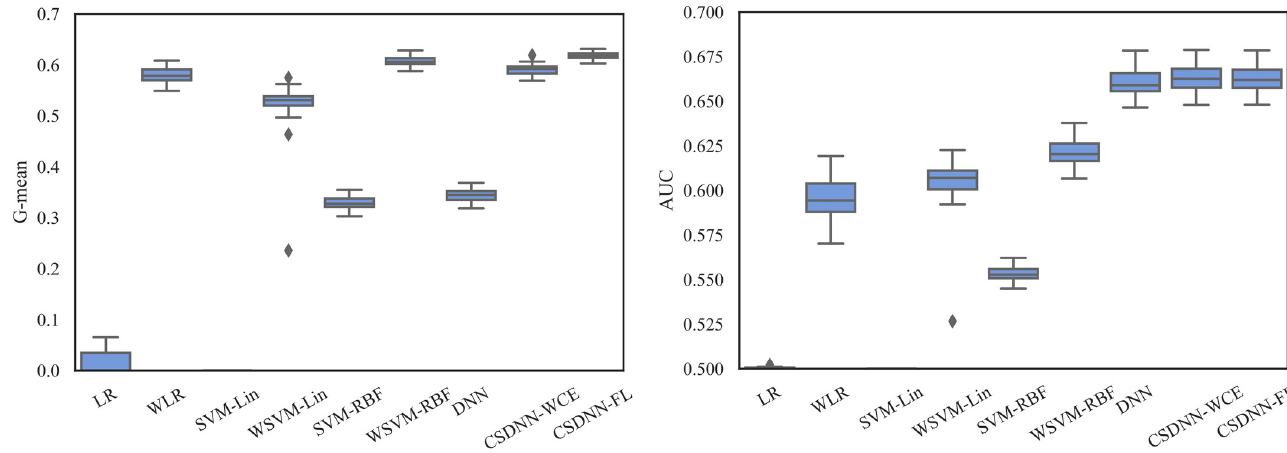
Fig 27. Robustness of CSDNN-FL and CSDNN-WCE in comparison to other ML algorithms for Texas dataset in terms of G-mean (left) and AUC (right).